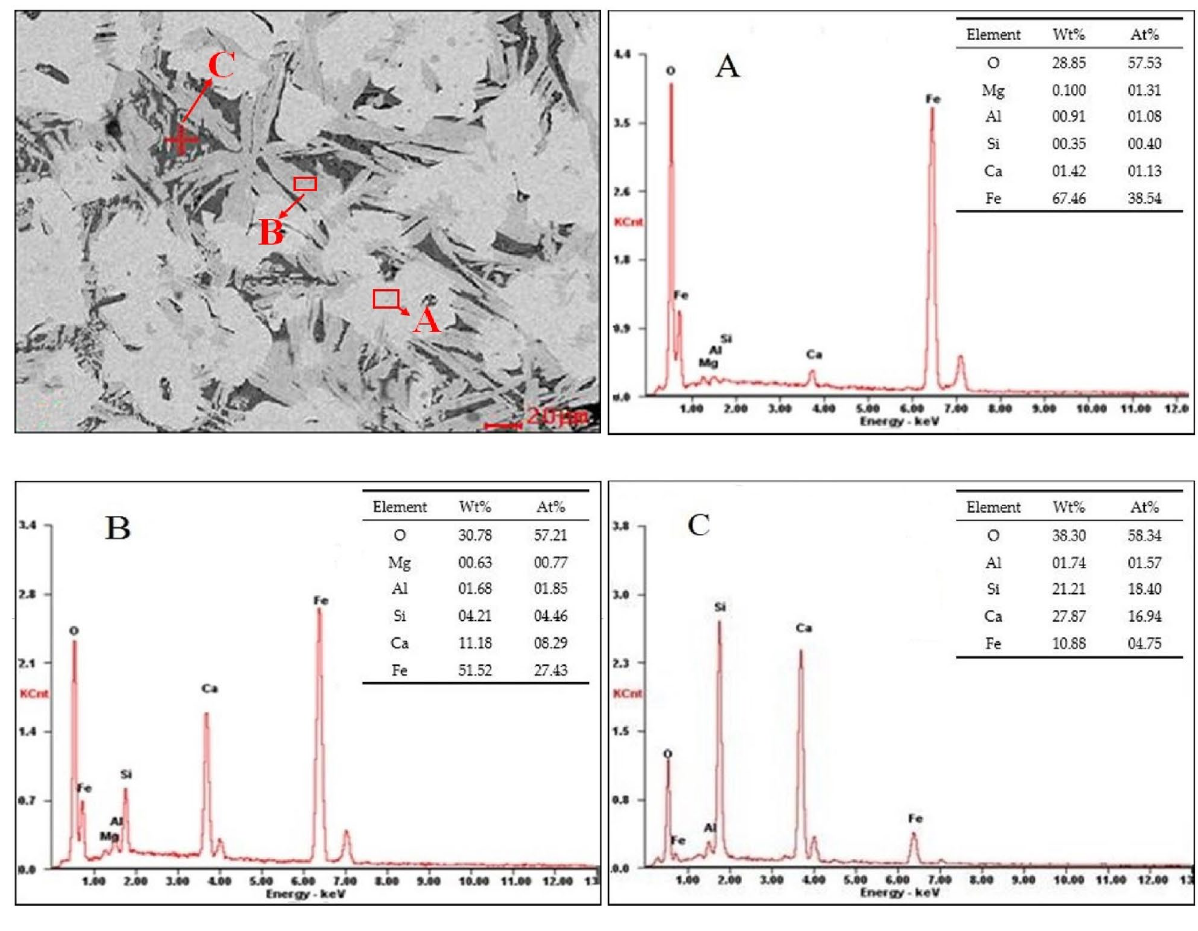
Figure 9. SEM images and EDS analysis results of the sinter for 40% anthracite substitution for coke breeze. Point A, Hematite (white); point B, calcium ferrite (grey); point C, complex silicate